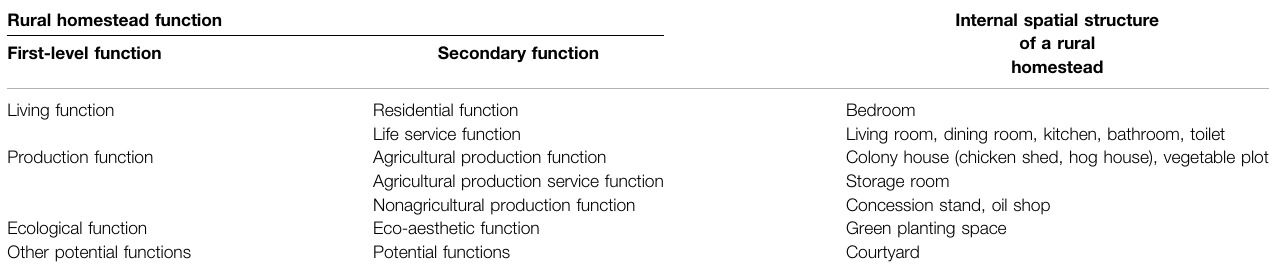
TABLE 1 | Internal spatial structure and functions of a rural homestead. Rural homestead